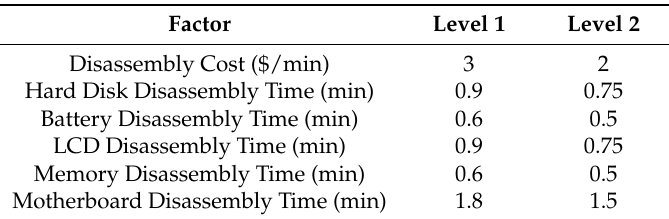
Table 2. Disassembly cost and time factors.